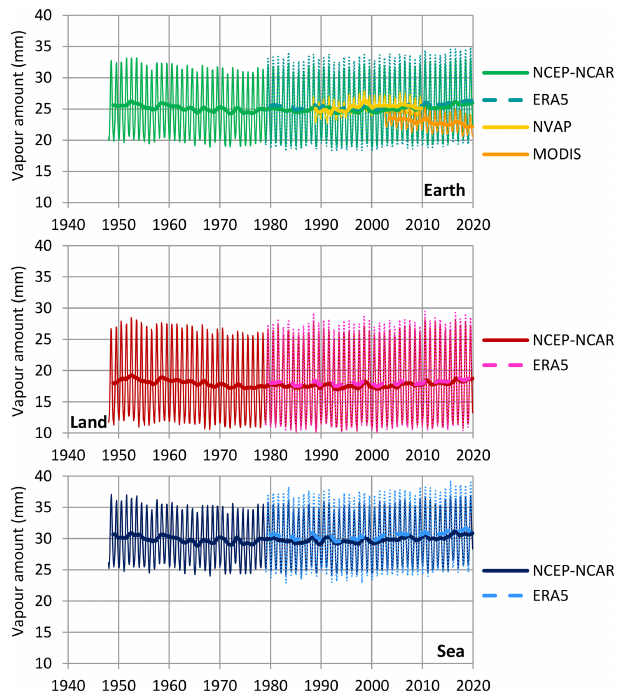
Figure 7. Variation of water vapour amount. Thin and thick lines of the same colour represent monthly values and running annual aver- ages (right aligned), respectively. Sources of the data are indicated in the legend and detailed in Table 1. The plotted values for MODIS represent the averages from the Terra and Aqua